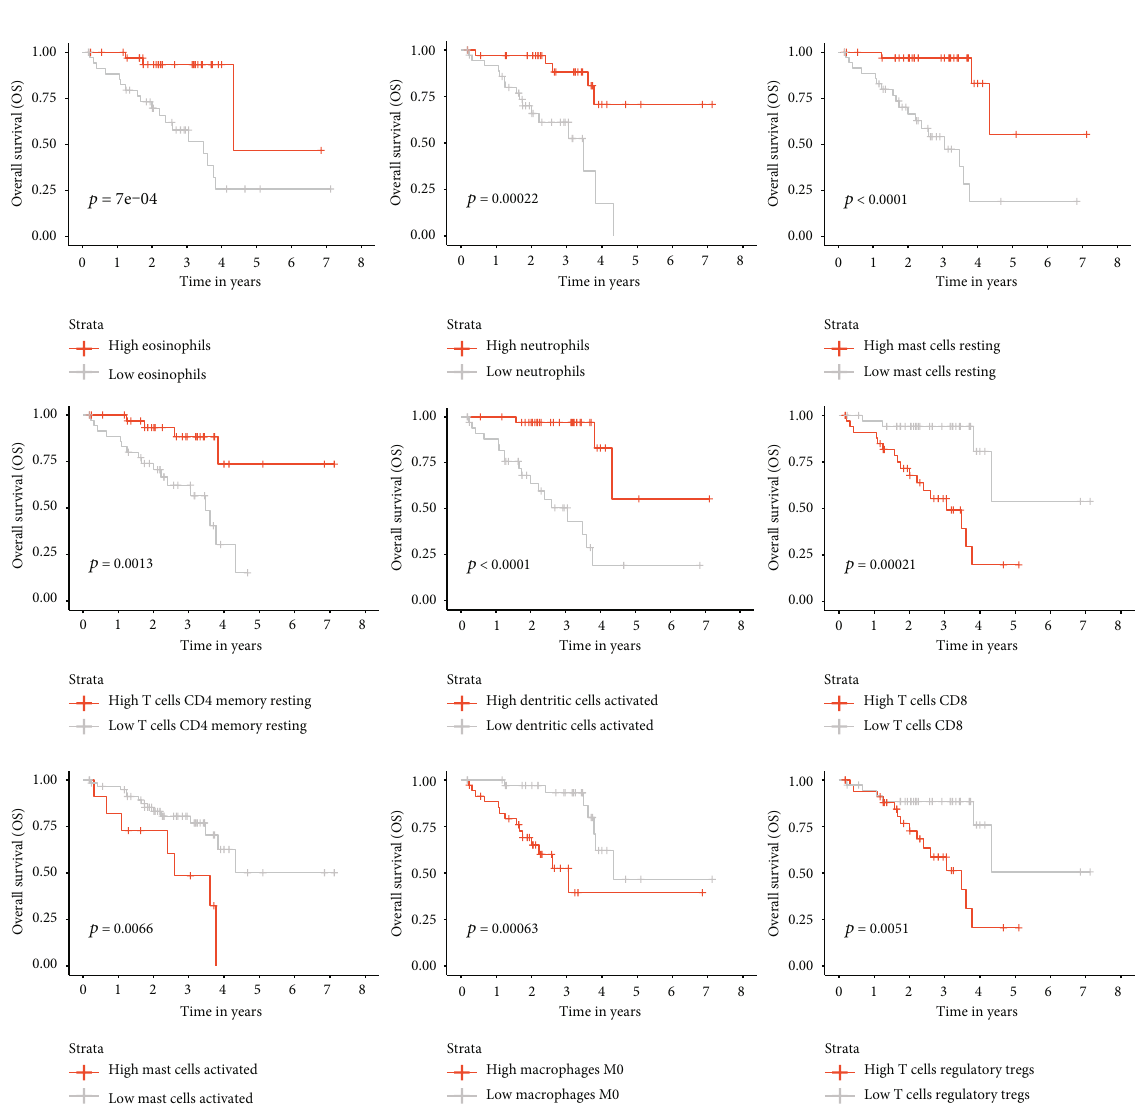
Figure 2: Kaplan-Meier survival analysis for training cohort based on median scores for each immune cell type. Only cell types characterized by a statistically signi fi cant prognostic e ff ect ( p < 0 : 05 ) are and neutrophils being statistically signi fi cant ( p < 0 : 0001 and p = 0 : 048 , respectively) (Figure 5).